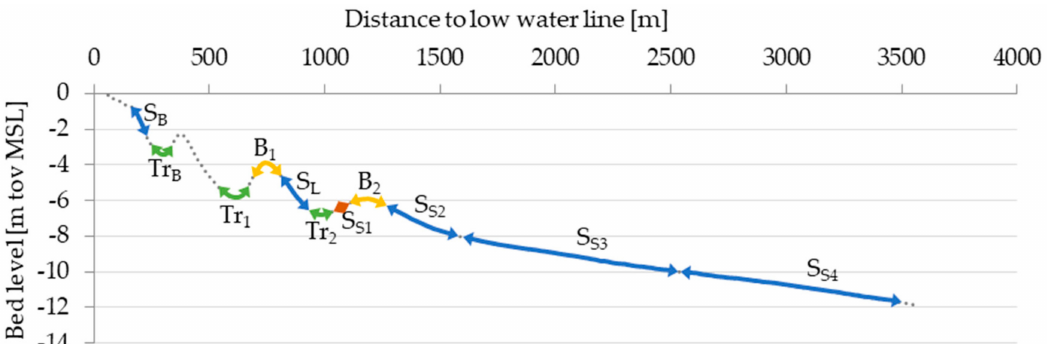
Figure 2. Schematic cross-shore profile of the nearshore of Ameland with morphological features. In seaward direction: (S B ) beach slope, (Tr B ) beach trough, (Tr 1 ) first trough, (B 1 ) first bar crest, (S S1 ) seaward slope first bar crest, (Tr 2 ) second trough, (S L ) landward slope second trough, (B 2 ) second